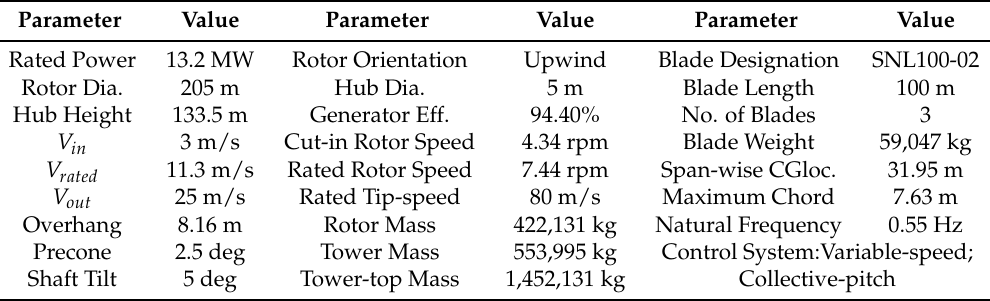
Table 2. Properties of wind turbine and blade model.